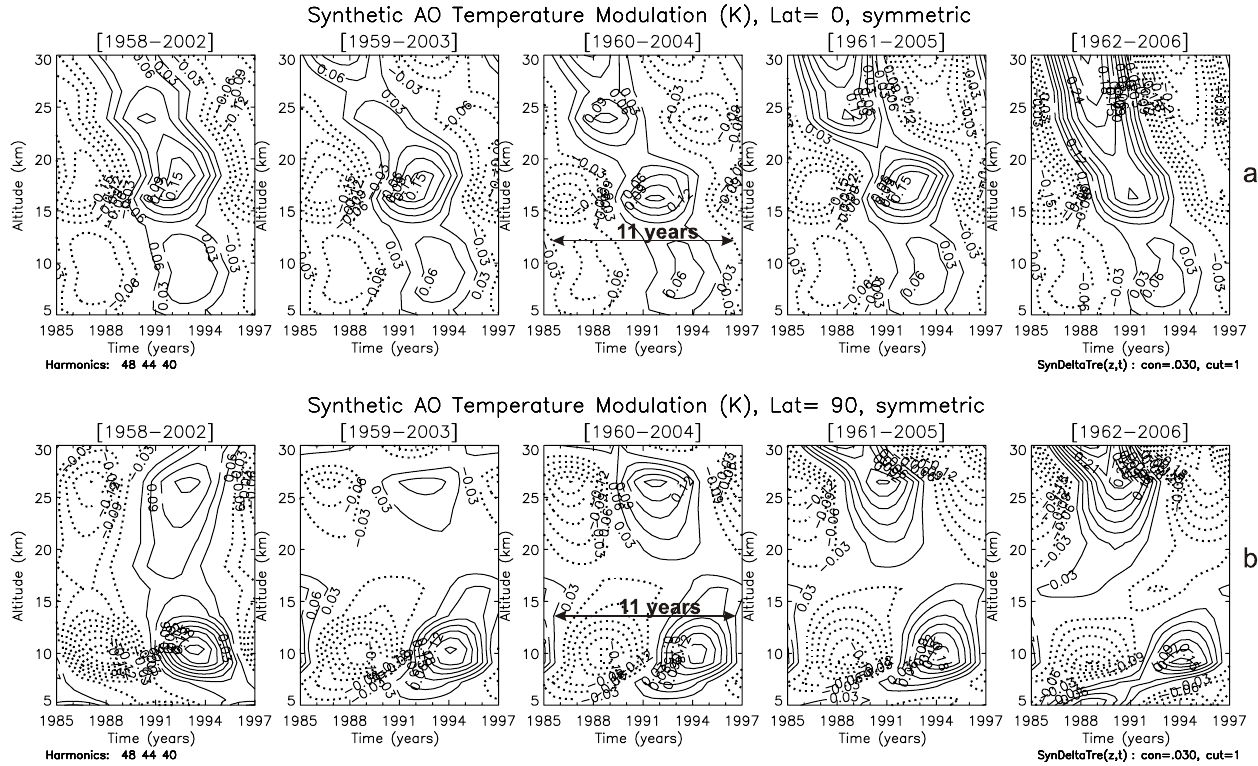
Fig. 5. Analogous to Fig. 3, synthesized temperature modulations of the symmetric AO for the moving 44-year time intervals at the equa- tor (a) , and pole (b) . At the equator (a), the 11-year modulation peaks between 15 and 20km, and the maximum occurs near 1992 in each of the windows. This indicates that the modulation is phase locked, possibly due to systematic forcing by the SC. This pattern is also apparent below 15km, but the variations at higher altitudes are erratic. (b) At the pole, systematic 11-year temperature modulations occur around 10km altitude, consistent with the corresponding signature in Fig.